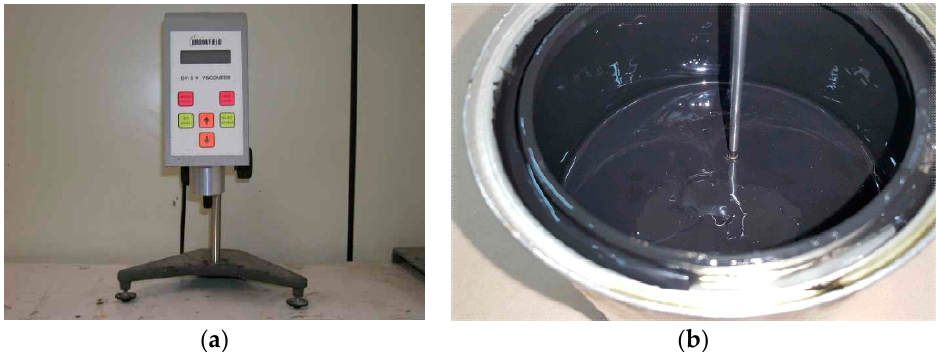
Figure 7. Brookfield viscometer; ( a ) apparatus; ( b ) measuring SPRG viscosity.